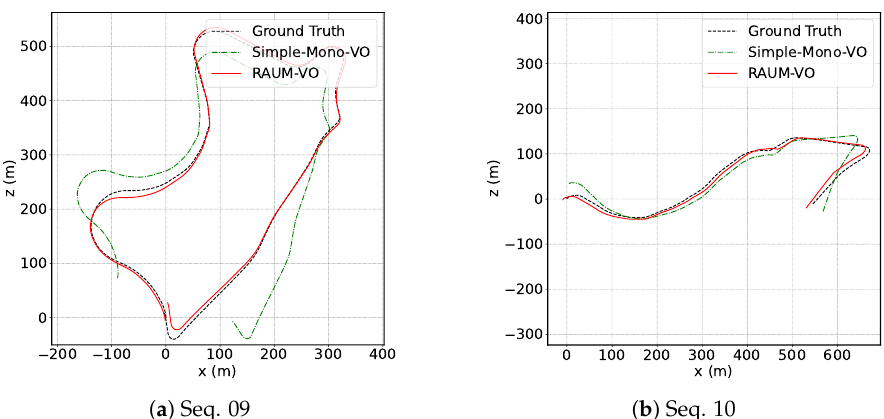
Figure 4. KITTI test trajectories. Estimated trajectories for the KITTI odometry sequences 09 and 10. Poses are given in camera frame. Thus, positive x means right direction and positive z means forward. Best viewed in color. Table 1. Odometry quantitative evaluation. Result obtained on KITTI odometry seq. 00–10. Data is retrieved from [16]. Best results are highlighted in bold , second best with an